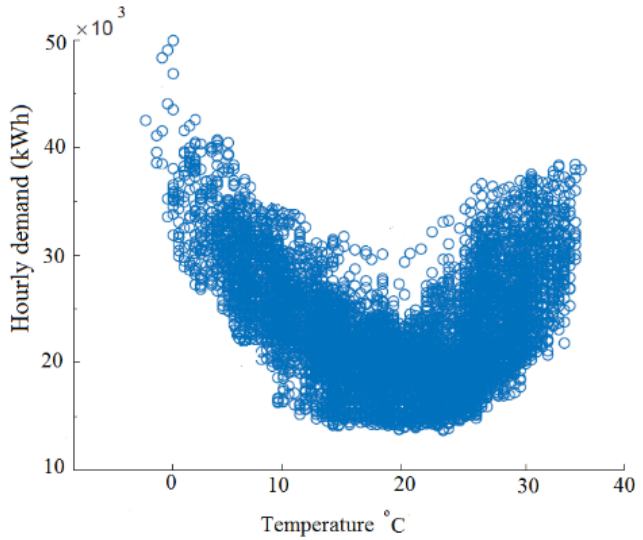
Figure 8. Scatter plot of hourly demand vs. temperature in Jordan